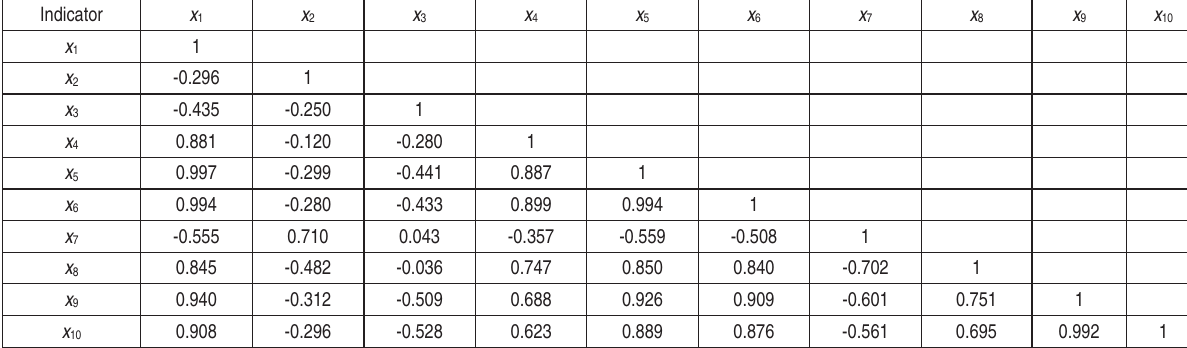
Table 1. Matrix of correlation of